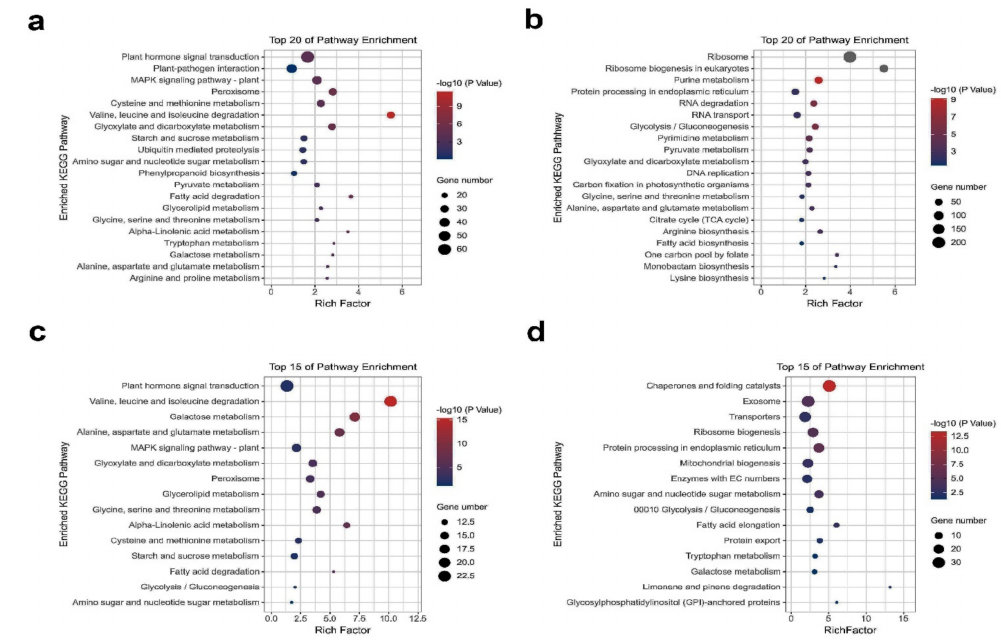
Figure 4. KEGG pathway enrichment analysis for differential gene expressions (DEGs) of high hybrids and its parents. ( a , c ) KEGG analysis of DEGs with an up-regulated and down-regulated overdominance pattern at 21 DAS, respectively. ( b , d ) KEGG analysis of genes with an up-regulated and down-regulated overdominance pattern at 24 DAS,